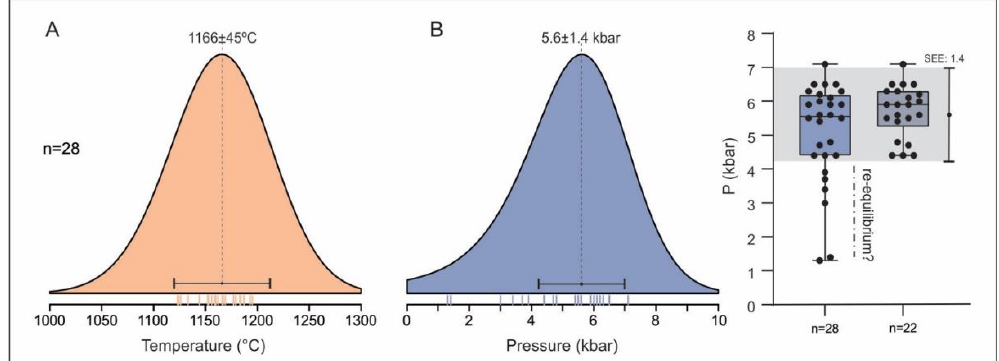
Figure 9. KDEs of temperatures and pressures calculated for the clinopyroxene antecrysts from PN using equations [66,68]. ( A ) Temperature KDEs is calculated with a bandwidth of 45 °C, as recommended in [66], with peak of estimations close to ~1180 °C. ( B ) Pressure KDEs is calculated with a bandwidth of 1.4 kbar, which is comparable to the SEE (1 σ ) of [68] barometer, with peak of estimations of pressure of ~5.6 kbar, accompanied by boxplot graph. Considering just the antecrysts with minimum re-equilibrium (n = 22), the peak of P is ~5.8 kbar, values also consistent with the medians obtained using boxplot graph.